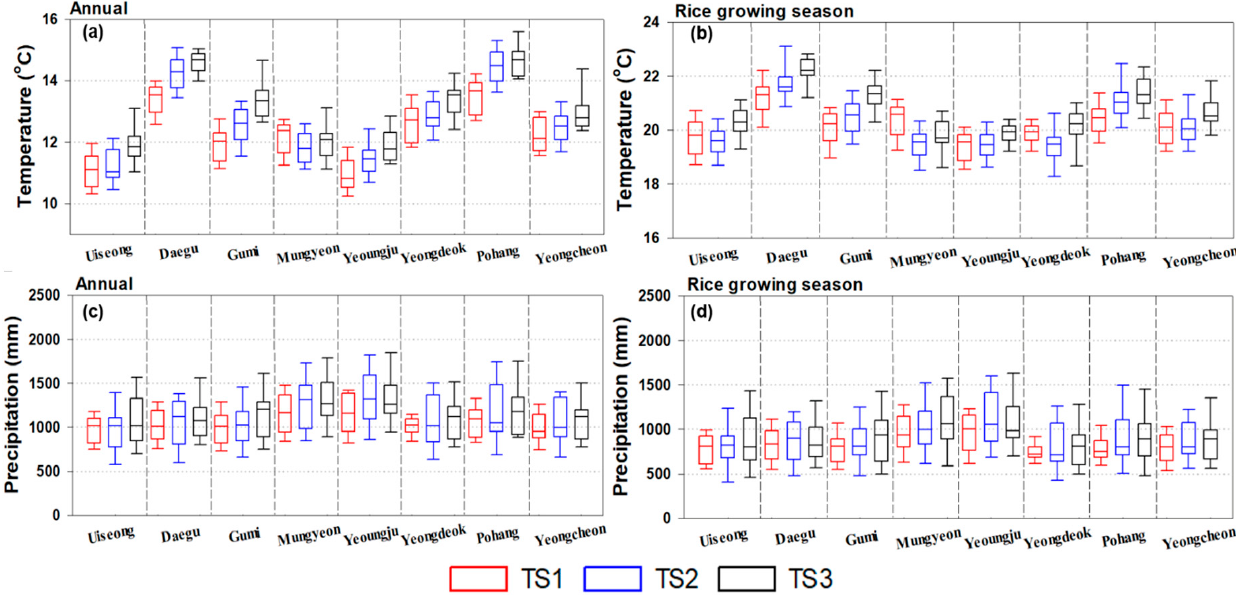
Figure 2. Evolution of annual and rice-growing season ( a , b ) mean temperature (T mean ) and ( c , d ) cumulative precipitation (P) during 1973–2017. The boxes in Figure 2 and below represent the interquartile ranges, the whiskers extend to the maximum and minimum values, and the horizontal lines inside boxes show median values.